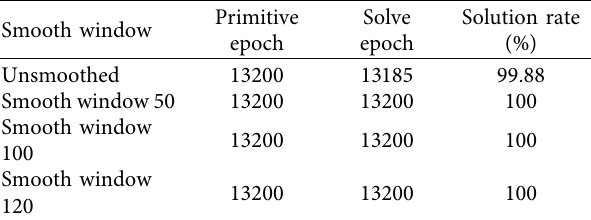
Table 4: Statistics of data solving rate. Smooth